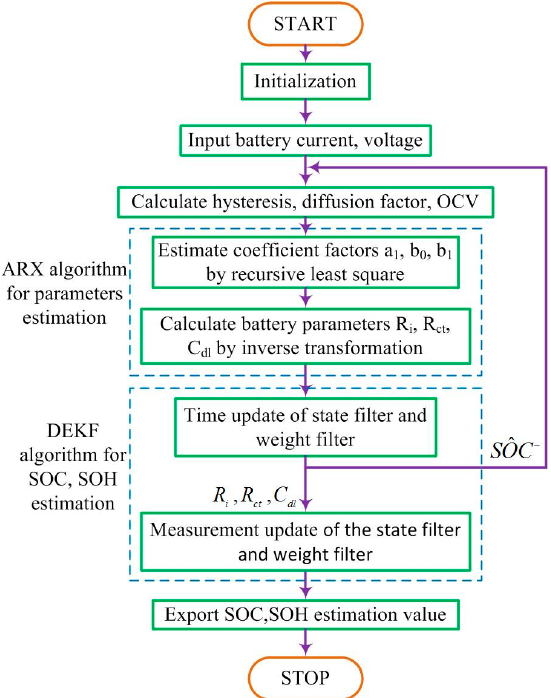
Figure 2. The proposed flowchart of the combination of ARX model and DEKF algorithm.